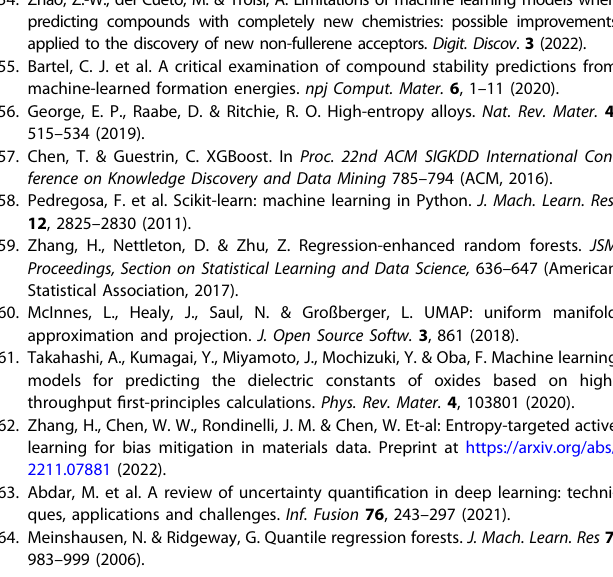
table: solid state applications. Dig. Discov . 25 – 33 (2023). https://doi.org/10.1039/